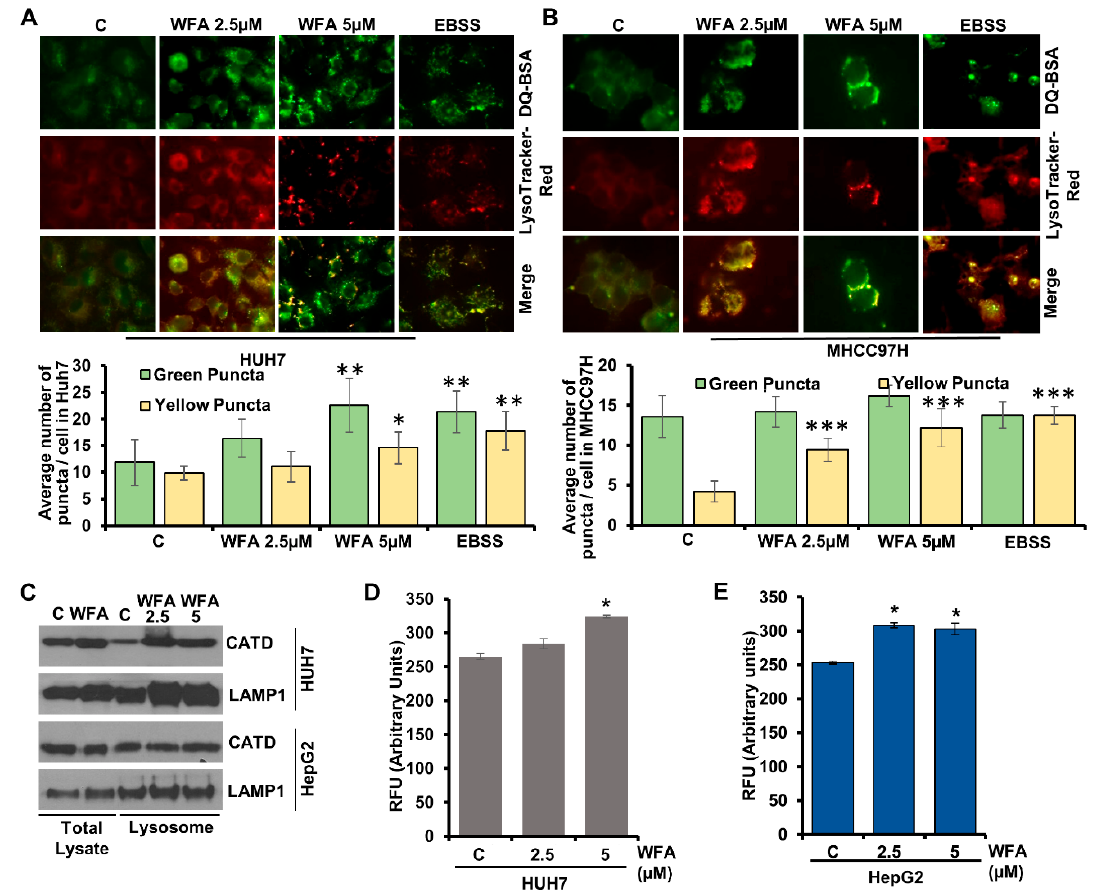
Figure 5. Withaferin A induces proteolytic degradation and Cathepsin D in lysosomes. ( A and B ) Huh7 and MHCC97H were treated with DQ-BSA followed by treatment with 5 µM of WFA or EBSS; fixed and stained with Lysotracker-Red. Representative images are shown. Bar diagrams show quantification of green and yellow puncta. * p < 0.05, compared with control; ** p < 0.01, compared with control; *** p < 0.001, compared with control. Scale bar 10 µm ( C ) Western blot analysis showing Cathepsin D and LAMP1 expression levels in the total cellular lysate and in the lysosomal extract of vehicle and WFA treated HUH7 and HepG2. ( D , E ) Cathepsin D activity assay using lysates from vehicle and WFA treated Huh7 and HepG2 cells.